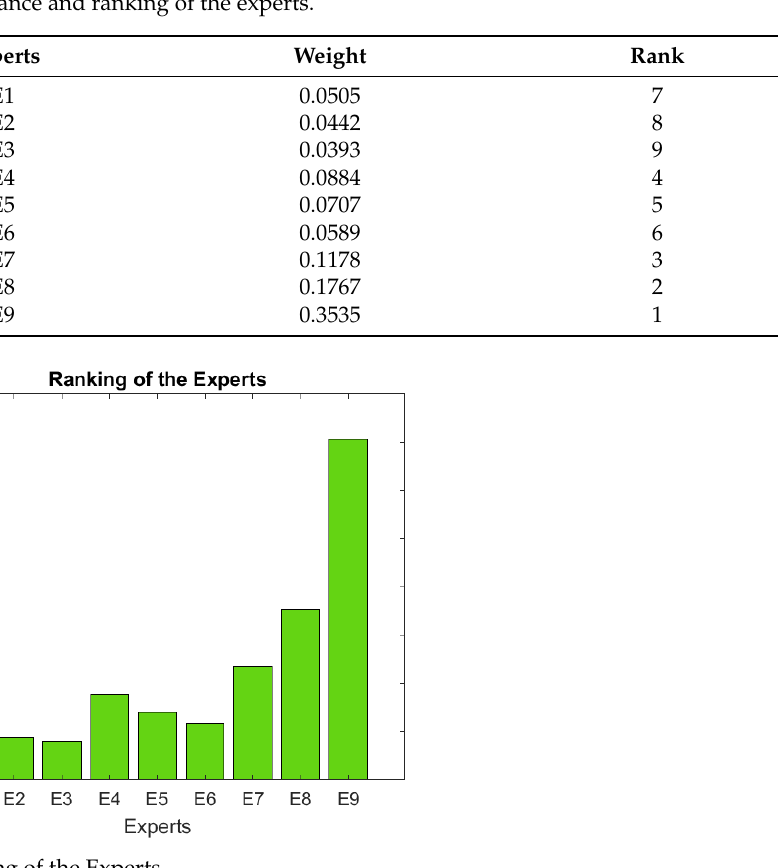
Figure 3. Ranking of the Experts.